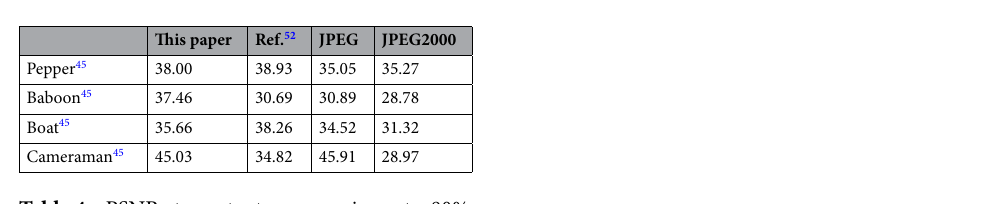
Table 4. PSNR at constant compression rate: